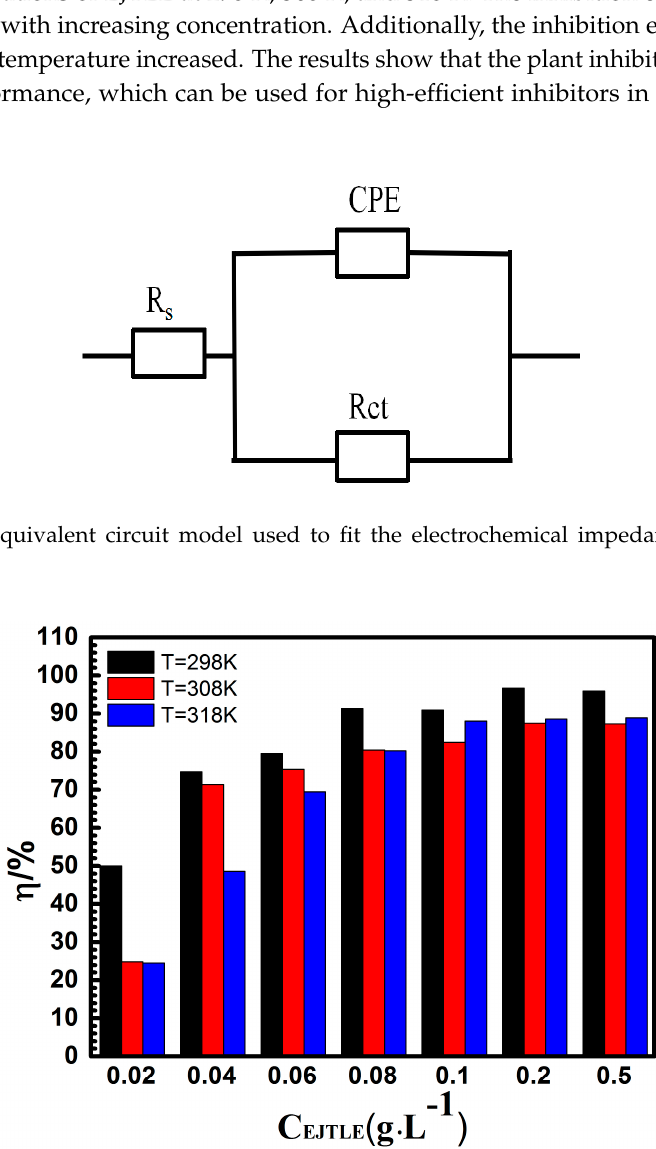
Figure 6. Variation of η in the presence of different concentrations of EJTLE at 298 K, 308 K, and 318 K.